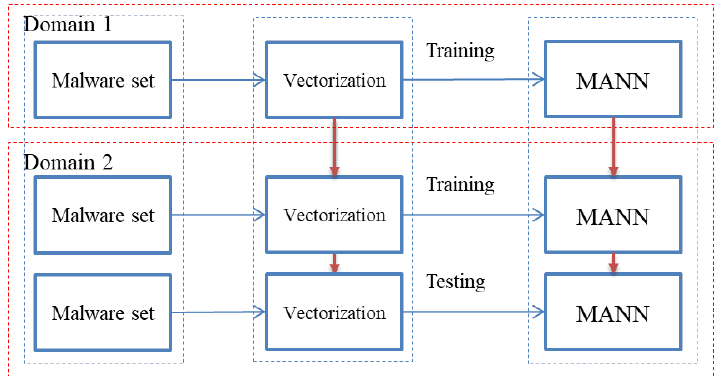
Figure 3. The proposed method contains two domains: the model is trained with familiar malware families in the first domain while in the second domain, the pre-trained model is used to classify unknown malware types with very few